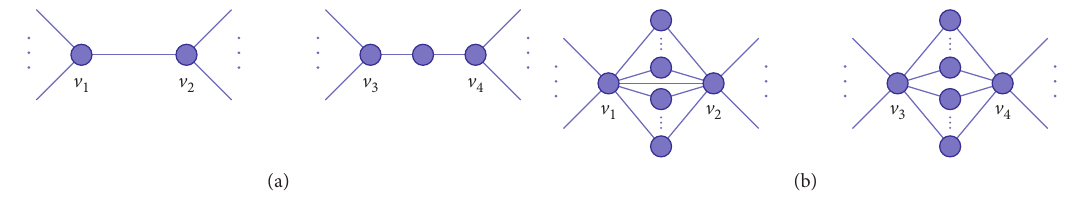
Figure 1: Two scenarios which generic common neighbor-based similarity might lead to problematic result.